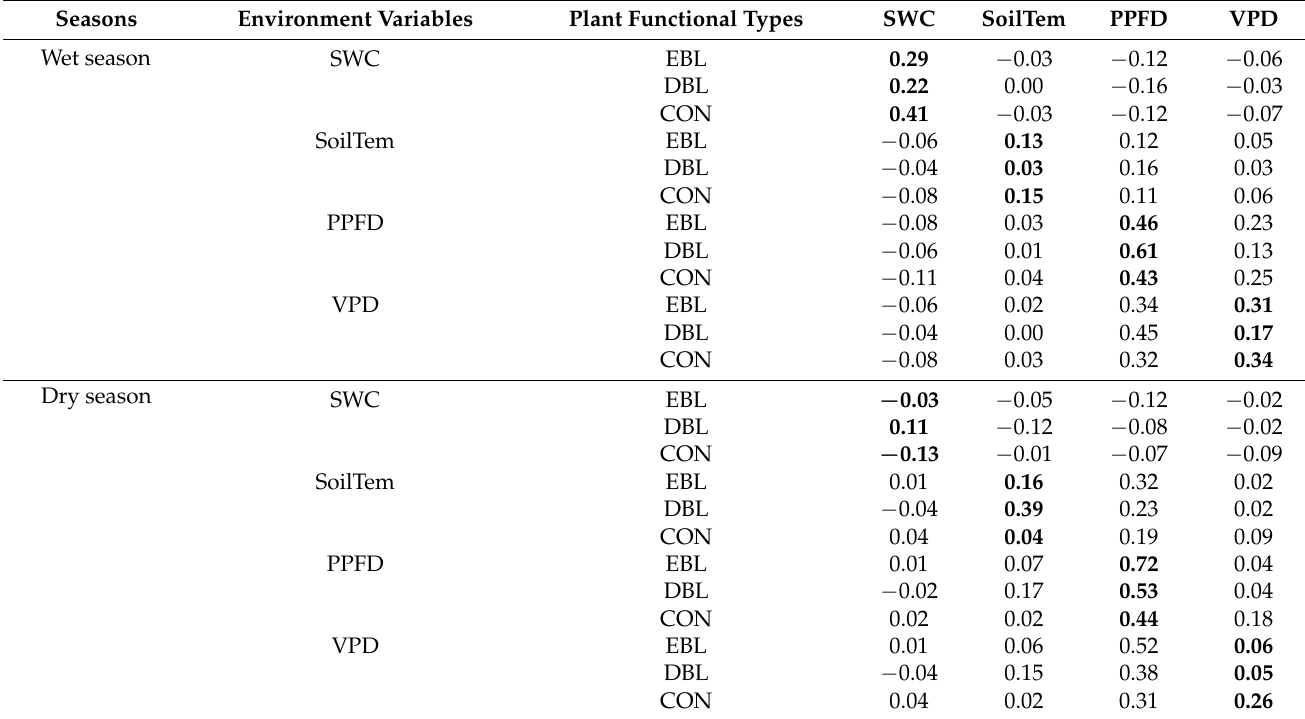
Table 2. Direct (in bold) and indirect effects of environment variables on sap flux densities in evergreen broad-leaved trees (EBL), deciduous broad-leaved trees (DBL), and conifers (CON) at the daily scale in the dry and wet seasons using path